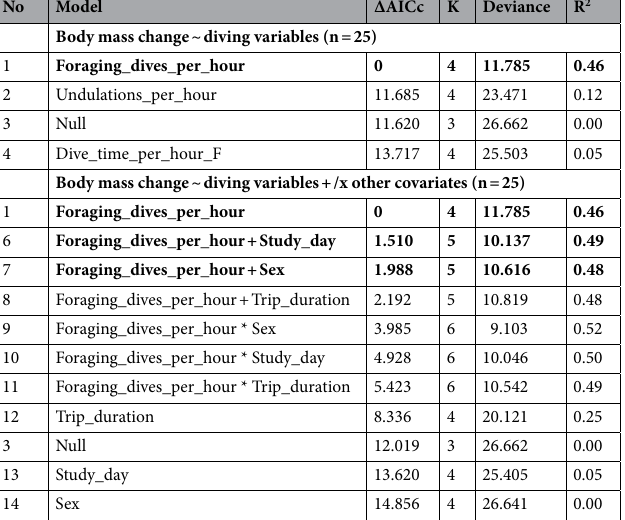
Table 1. Modelling the foraging success (in terms of body mass change over a foraging trip) according to behavioral (diving) variables (and other covariates) for breeding Adélie penguins at Cape Crozier, Ross Island, 2018/2019. Models within 2 ΔAICc of the best model are in bold. Models were fitted using maximum likelihood estimation with bird ID as a random effect. R 2 = marginal r-squared value for mixed models from Nakagawa et al. 59